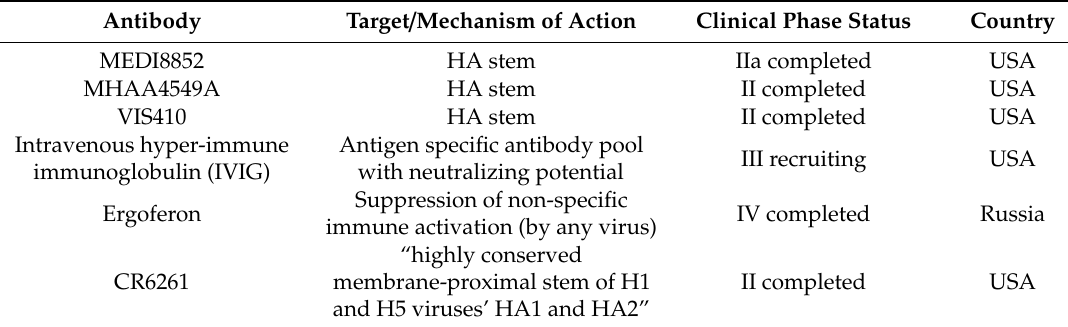
Table 3. Antibodies undergoing clinical trials.